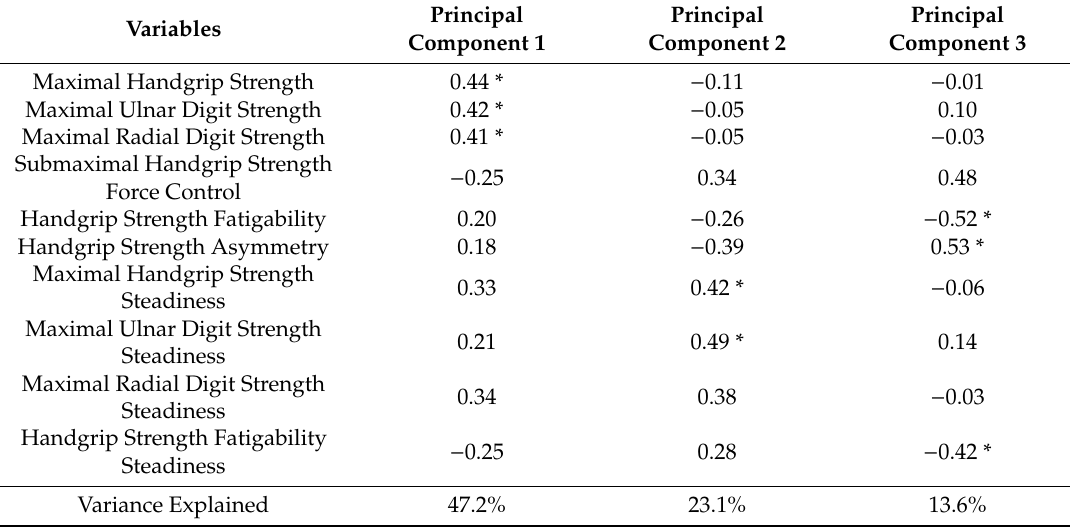
Table 3. Factor loadings for the principal component analysis of the handgrip strength